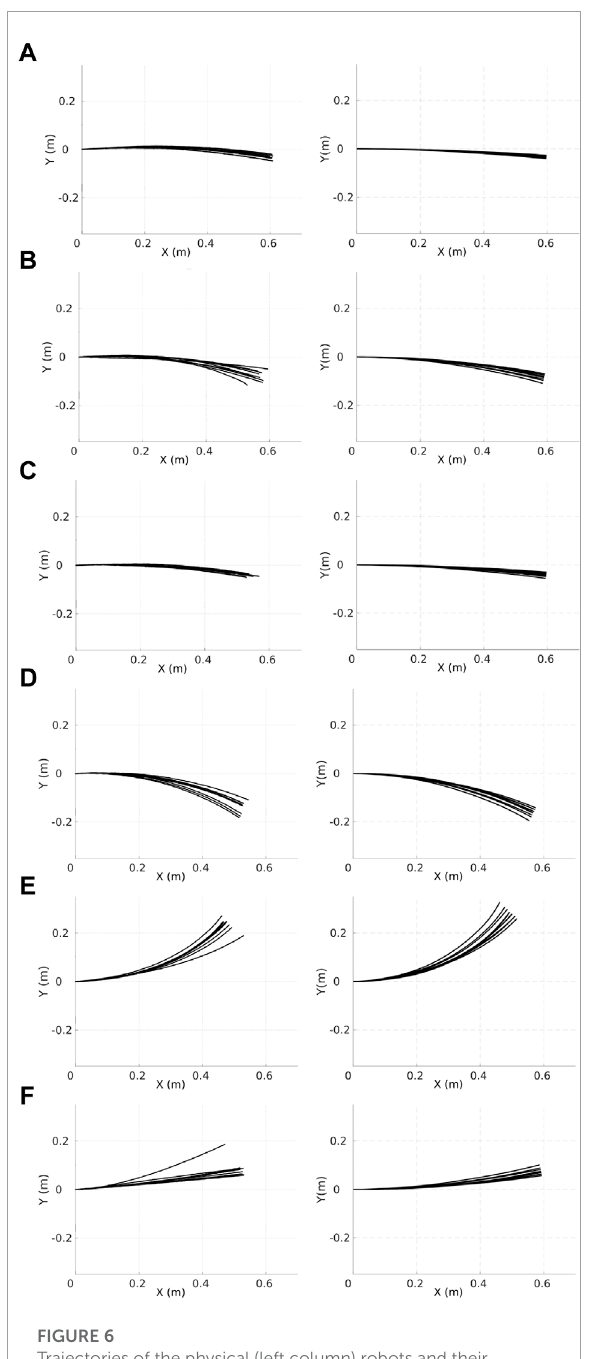
FIGURE 6 Trajectories of the physical (left column) robots and their respective simulated versions (right column). Each character ( A–F ) represents the ID of each different robot where, each robot moves forward along the x -axis for 30 s at a speed of 0.02 m/s, and 10 iterations are shown for each robot. X(m) and Y(m) represent the coordinates of the